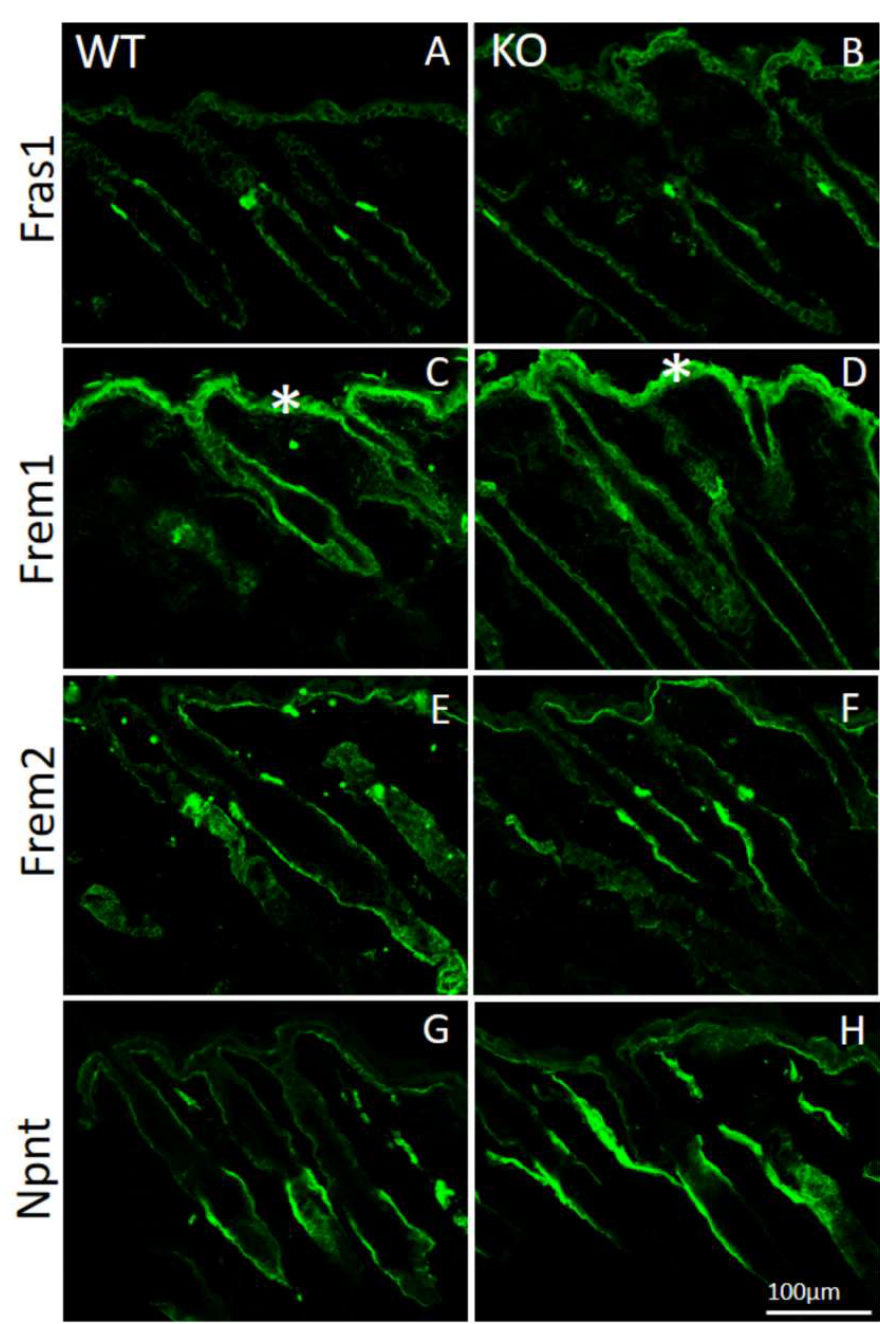
Figure 4. Immunofluorescence analysis of Fraser complex proteins in AMACO-deficient P16 mouse skin. Frozen sections of skin from wildtype ( A , C , E , G ) and AMACO-deficient P16 mice ( B , D , F , H ) were incubated with affinity-purified Fras1, Frem1, Frem2, and nephronectin antibodies, followed by AlexaFluor 488-labeled secondary antibodies. Each Fraser complex component localizes similarly in WT and AMACO-deficient skin. Asterisks (*) show regions of unspecific staining with the Frem1 antibody. Scale bar = 100 µm for ( A – H ).